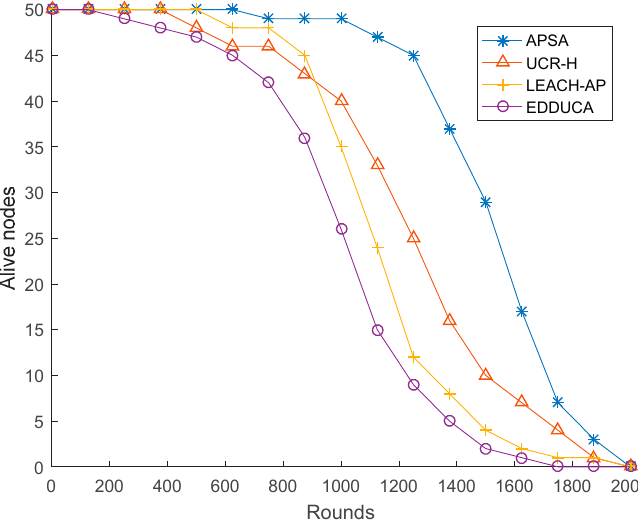
Figure 6. Alive nodes (50 sensor nodes).